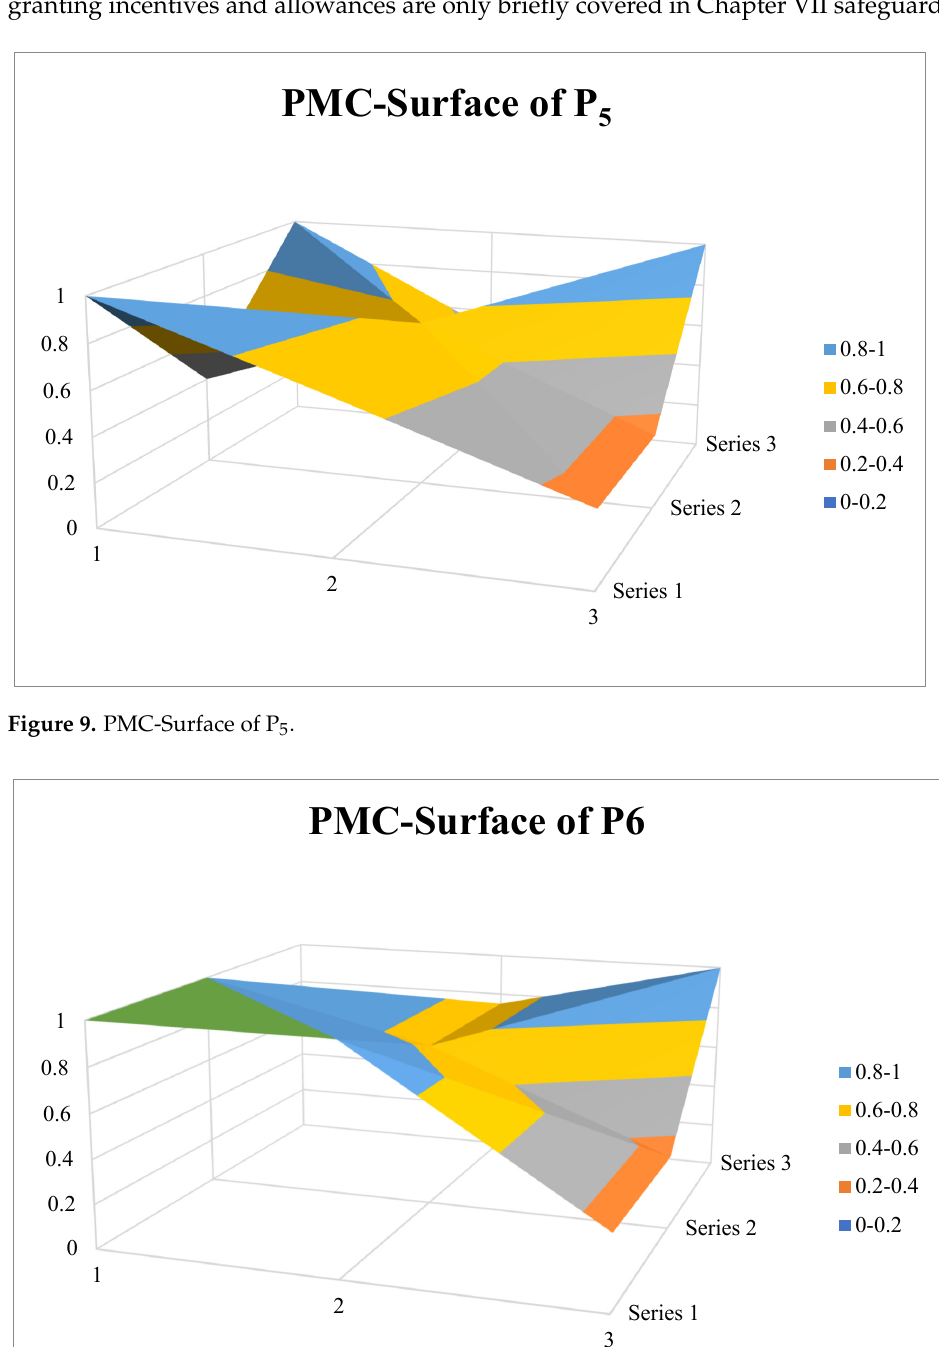
Figure 10. PMC-Surface of P 6.